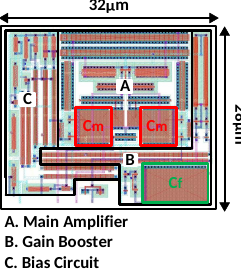
Figure 8. Layout of the proposed amplifier in 130-nm technology.